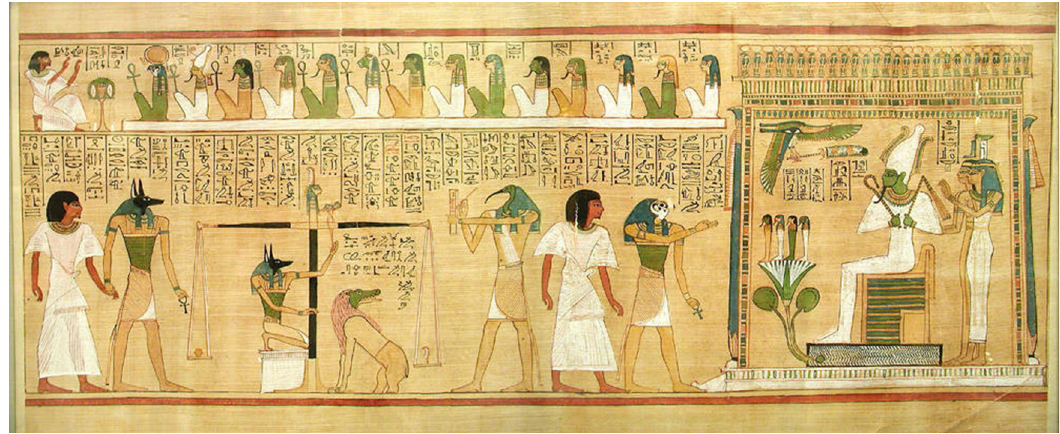
Fig. 1. Weighting of the heart at the judgement of the soul. Source: